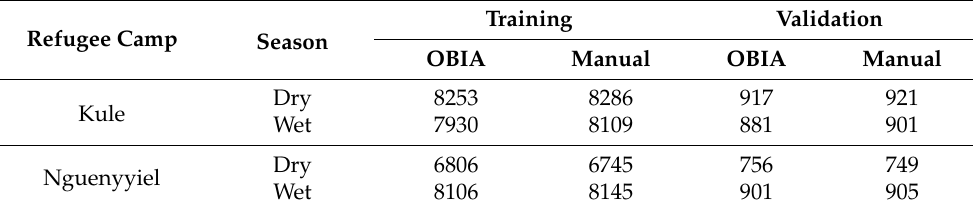
Figure 4. The brief process of data preparation. Table 1. The number of training and validation patches for the OBIA labels and Manual labels. Refugee Camp Refugee